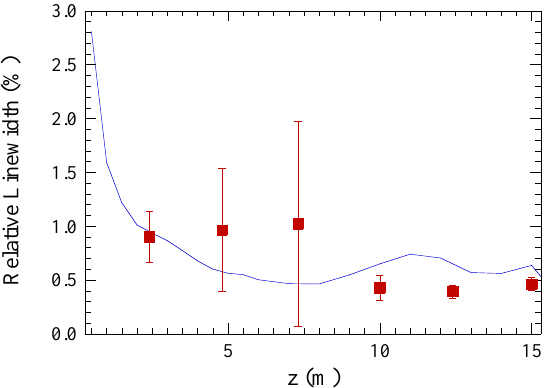
Figure 3. Simulated (blue line) and measured (red data points) relative linewidth as a function of the propagation distance z for the SPARC experiment. The error bar indicates the error in the measurement. The simulation result is, on average, over 20 noise